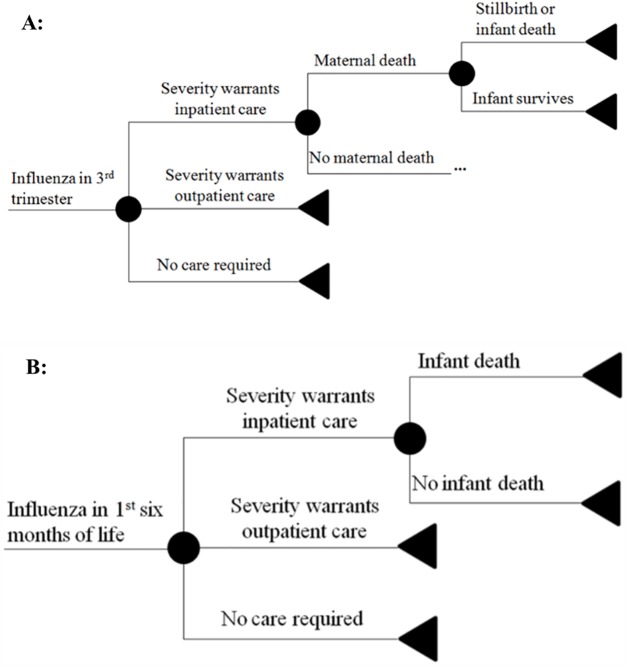
Influenza sub-tree structures.(A) Series of events that determine the monetary and utility costs of influenza infection during pregnancy. (B) Series of events that determine the monetary and utility costs of influenza infection during the first 6 months of life.